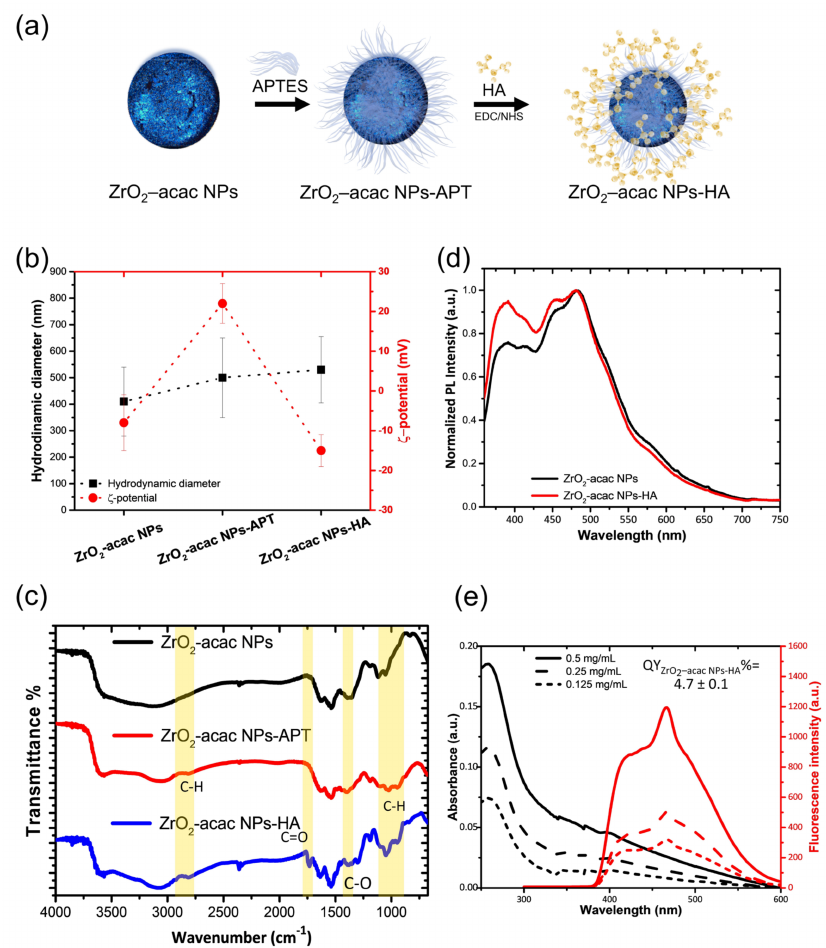
Figure 3. ( a ) Functionalization scheme. ( b ) DLS characterization of ZrO 2 -acac NPs, ZrO 2 -acac NPs-APT, and ZrO 2 -acac NPs-HA. ( c ) FTIR analysis of NPs after each functionalization step. ( d ) Photoluminescence spectra of the NPs before and after the functionalization with hyaluronic acid at the excitation wavelength of 325 nm. ( e ) Absorbance and relative photoluminescence of ZrO 2 -acac NPs-HA at different concentrations. Results are expressed as the mean ± s.d. ( n ≥ 3). FTIR characterization was performed within the wavelength of 4000 − 600 cm − 1 to evidence both the presence of the acac ligand in the ZrO 2 -acac and the bond formation in the functionalized NPs (Figure 3c). The FTIR spectra show the characteristic vibrations of –OH groups at about 3340 cm − 1 ( ν O − H ) and 1626 cm − 1 ( δ HOH ). The Zr-O-Zr-associated peak lies in the fingerprint region below 600 cm − 1 , as known from the literature, and therefore cannot be appreciated in the graph. The C=C stretching ( ν C = C ) of enol groups at 1533 cm − 1 and the peaks at 1376 cm − 1 and 1283 cm − 1 , corresponding to the stretching of the delocalized C − O bond ( ν C − O ), confirm that the ultrasound treatment did not disrupt the coordination bond between acac and ZrO 2 [17,33]. In the FTIR spectra of the ZrO 2 - acac NPs-APT, peaks related to the stretching vibration of C–H ( ν C − H ) in the alkyl chain of the APTES appeared at 2923 cm − 1 and 2950 cm − 1 , alongside a peak at 1027 cm − 1 , corresponding to the Si-O bond stretching. ( ν Si − O ). The functionalization with HA was confirmed by the presence of the peaks at 1740 cm − 1 and 1310 cm − 1 , which were related to the stretching mode of the ester ( ν C − O ) in the